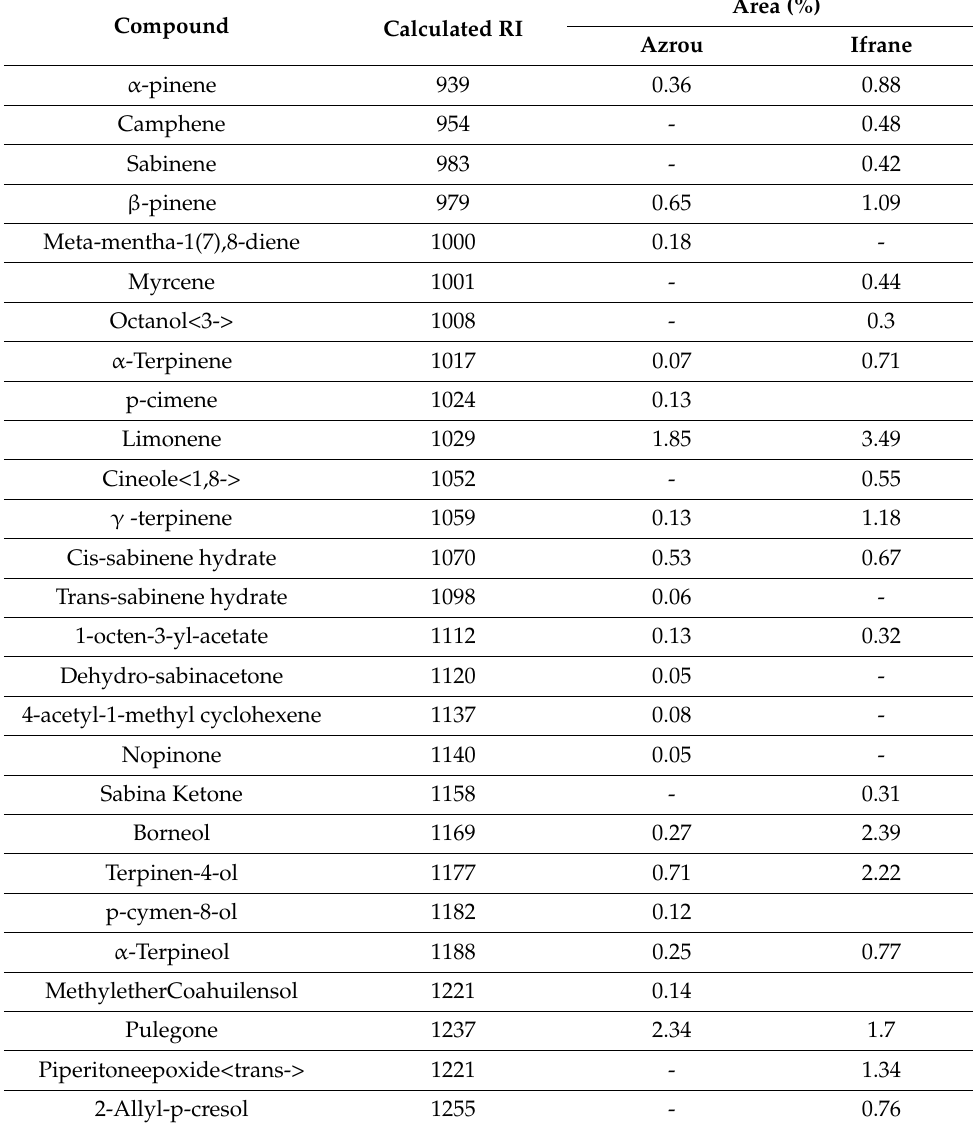
Table 4. Chemical composition of M. Suaveolens (L.) EOs from the Middle